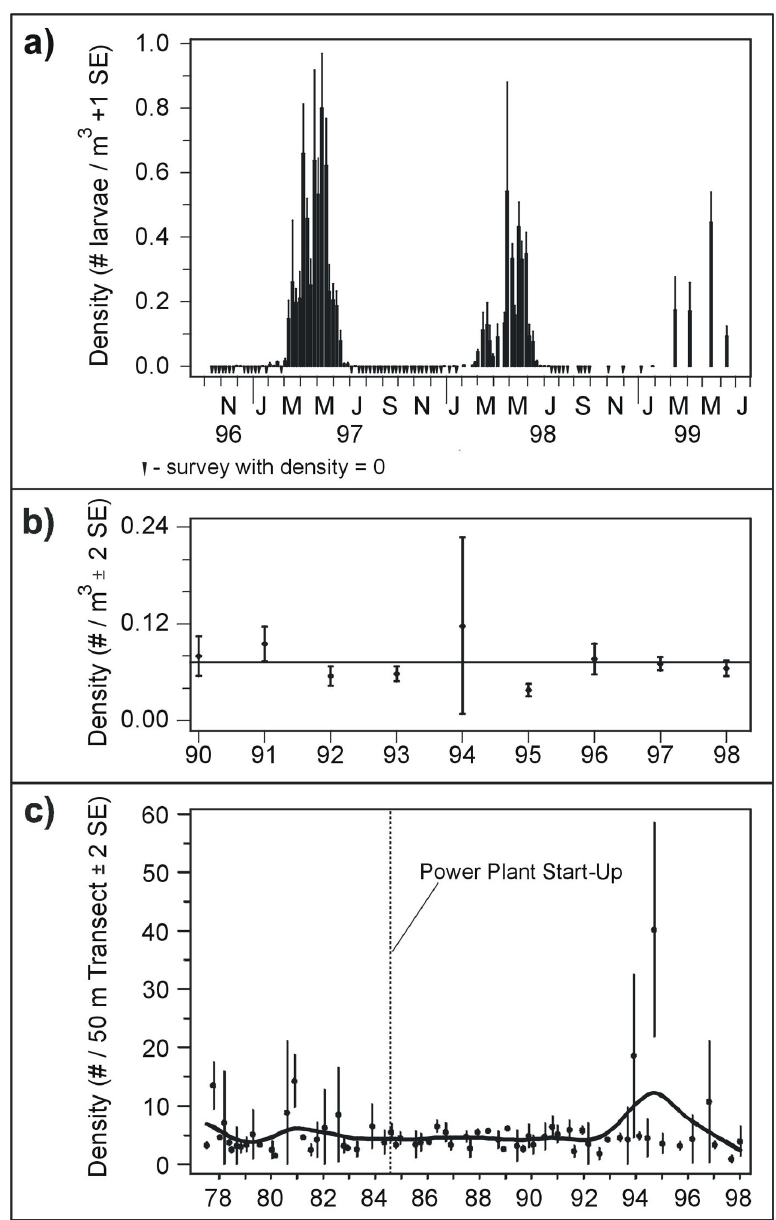
FIGURE 4. (a) Weekly mean density of larval KGB rockfish (#/m 3 + 1SE) at the DCPP intake. (b) Annual mean density ± 2 SE of larval KGB rockfish (vertical lines) and grand mean density for all years combined (horizontal line) for the intake cove surface plankton tows. (c) Mean density of juvenile and adult KGB rockfish (#/50 m transect ± 2 SE) estimated from SCUBA surveys in an area 700 m south of the DCPP intake cove. Spline smoothing algorithm used to draw the curve through the